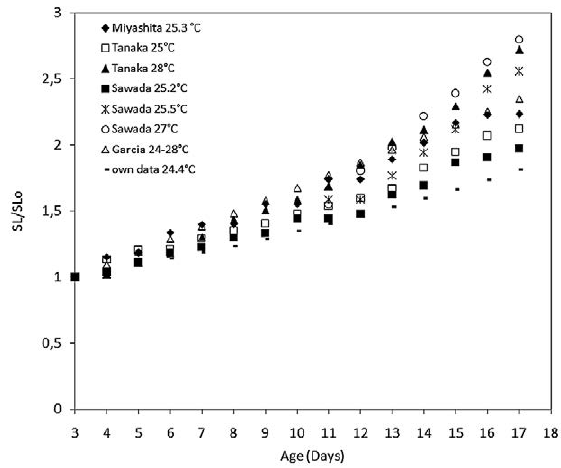
Fig . 6. – Comparison of larval growth rates. The standard length at age relative to the estimated initial length. Data from different laboratory experiments and temperatures with bluefin tuna larvae (Miyashita et al. 2001, Sawada et al. 2005, Tanaka et al. 2008), field reported data (Garcia et al. 2006) and our own